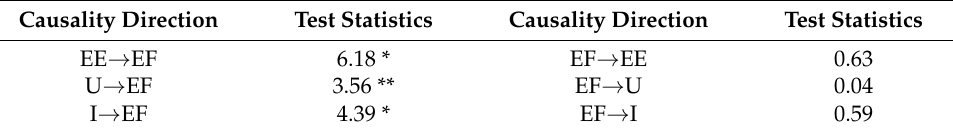
Table 8. Results of panel causality test.